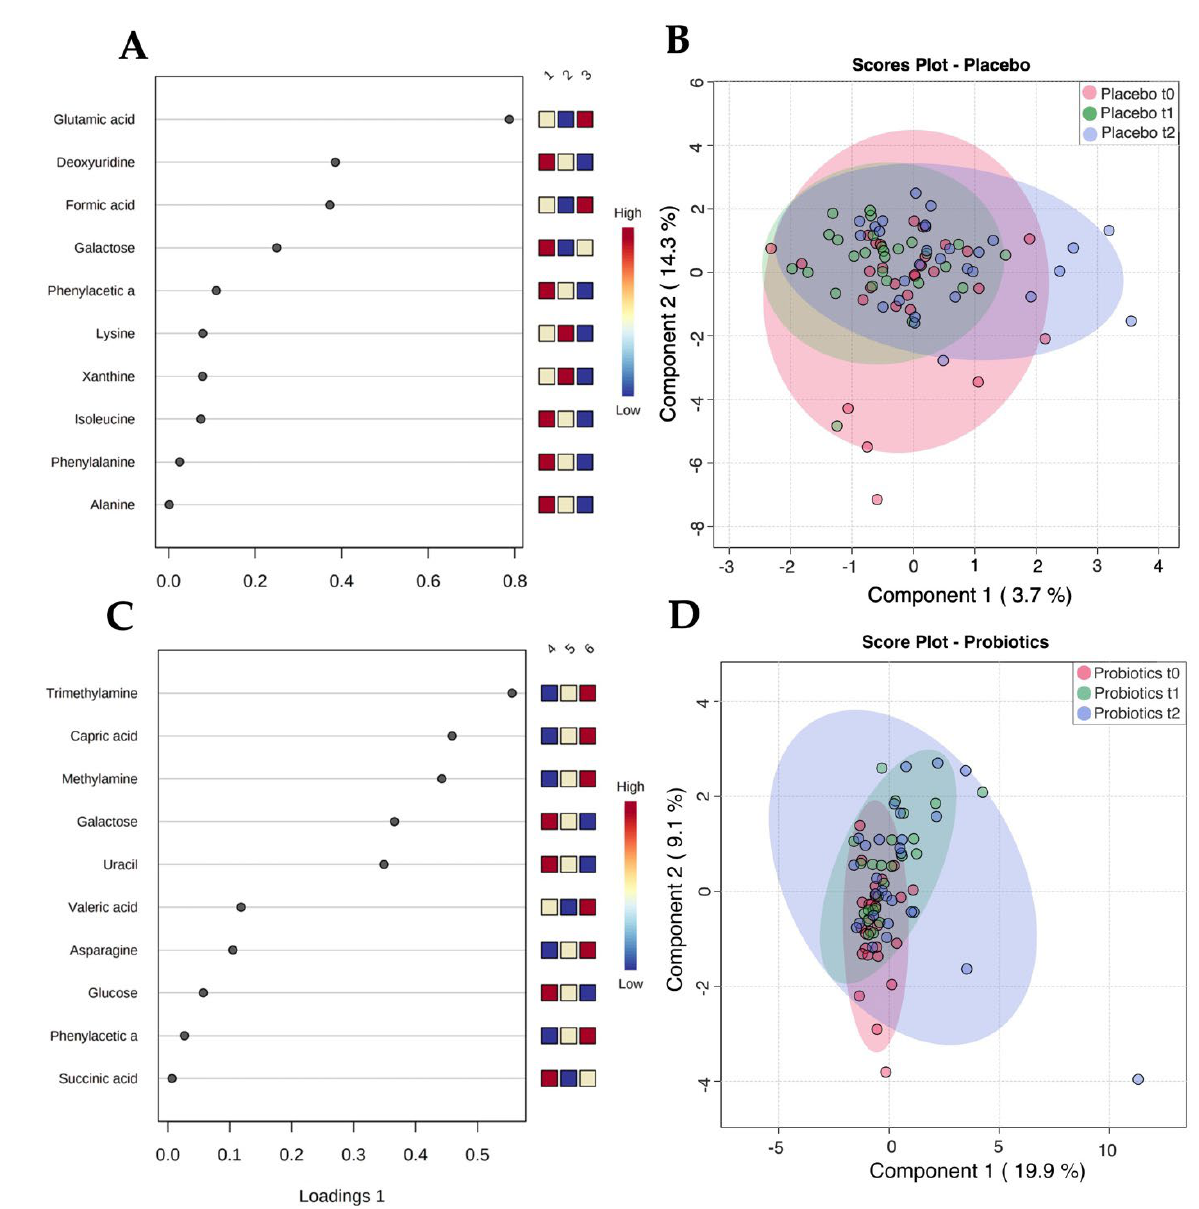
Figure 4. Untargeted metabolomics ( A ) of the placebo group ( n = 29) in stool. Features indicating most distinctive metab- olites. A heatmap is illustrated on the right side next to the table with the listed features, showing changes in concentration. Time points: (1) Admission t 0 , (2) two-week follow up t 1 , (3) end of the trial t 2 in the placebo group ( n = 28). ( B ) sPLS-DA scores plot of the placebo group ( n = 29) in stool: Component 1 of 3.7% and Component 2 of 14.3%. ( C ) Untargeted metab- olomics of the probiotics group ( n = 28) in stool. Features indicating most distinctive metabolites. A heatmap is illustrated on the right side next to the table with the listed features, showing changes in concentration. Time points: (4) Admission t 0 , (5) two-week follow-up t 1 , (6) end of the trial t 2 in the intervention group ( n = 29). ( D ) sPLS-DA scores plot of the probiotic group ( n = 28): Component 1 of 19.9%, Component 2 of 9.1%.